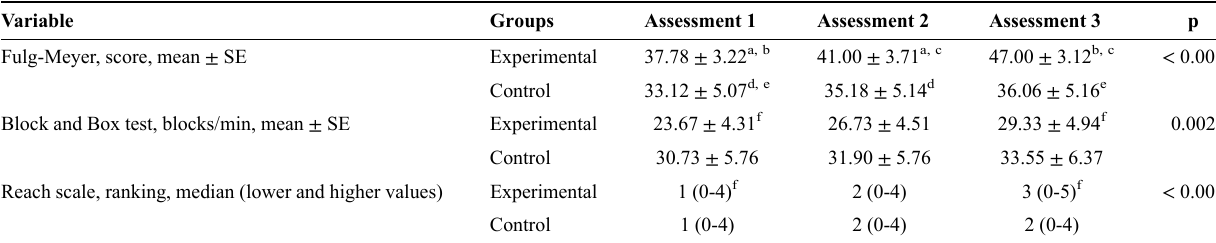
Table 2 - Comparison of treatment results in the experimental and control groups. Variable